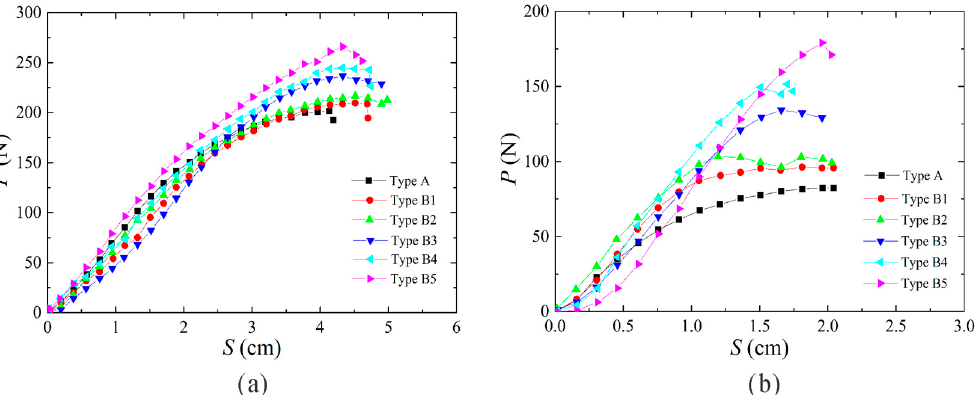
Figure 5. Load–displacement curves of the TAs under oblique and horizontal pullout loading ( a ) α = 0°; ( b ) α = 45°.